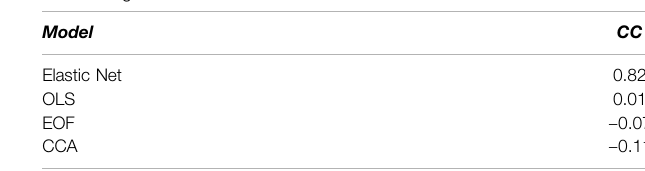
TABLE 1 | Correlations between L and prediction skill at varying lead times for different regression